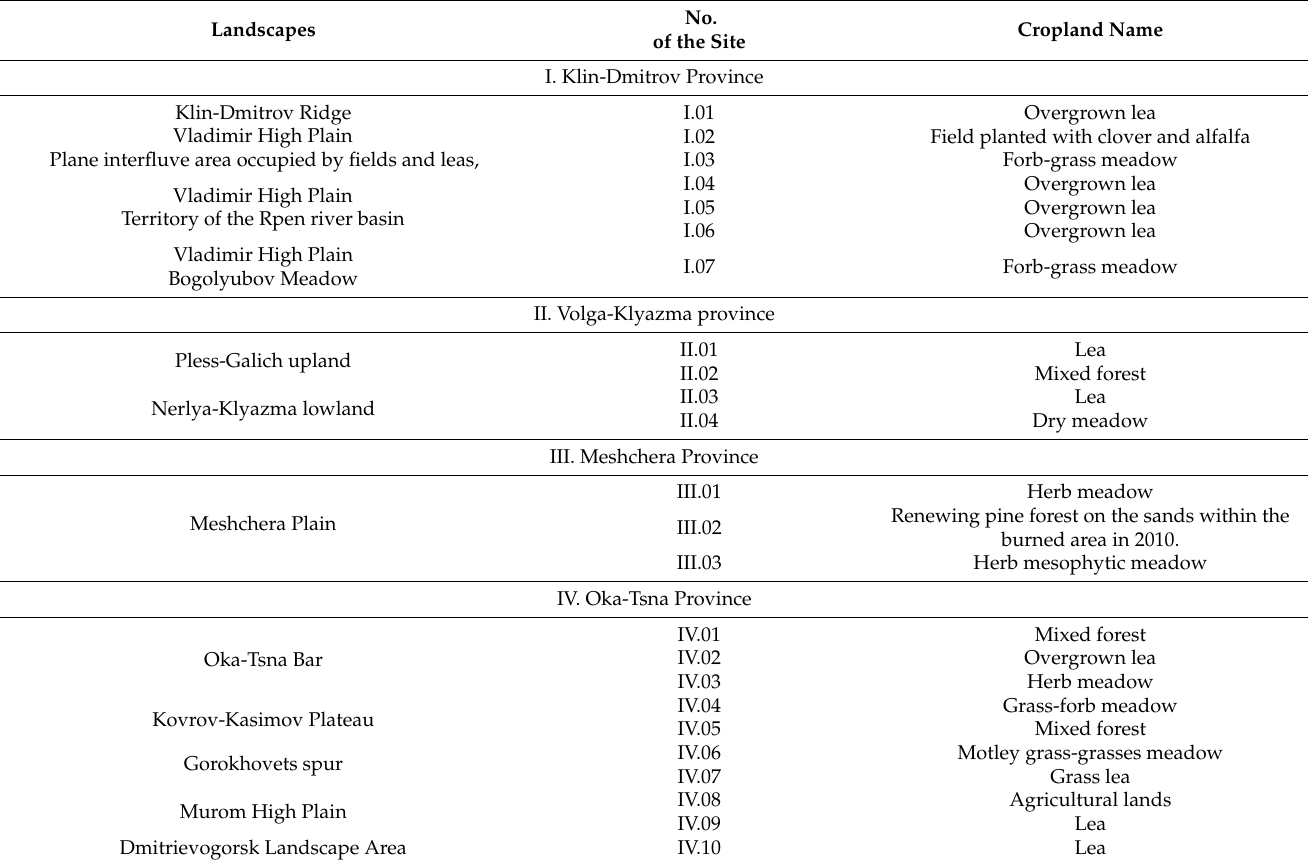
Table 1. Characteristics of control sites (sections) of the Volga-Oka interstream area.